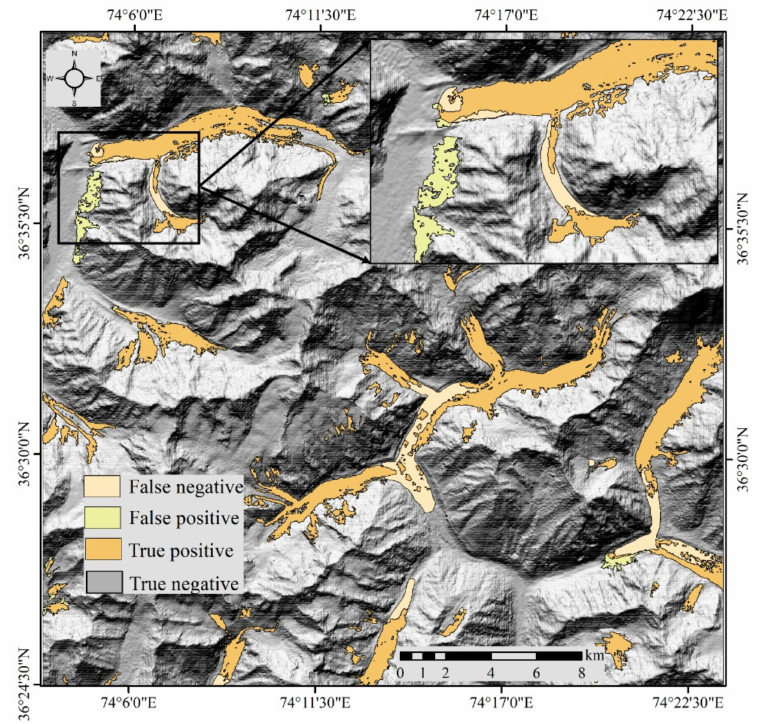
Figure 7. Supraglacial debris mapping at test site 2 (Karakoram) using the proposed algorithm. False-positives and false-negatives are mapped manually using reference